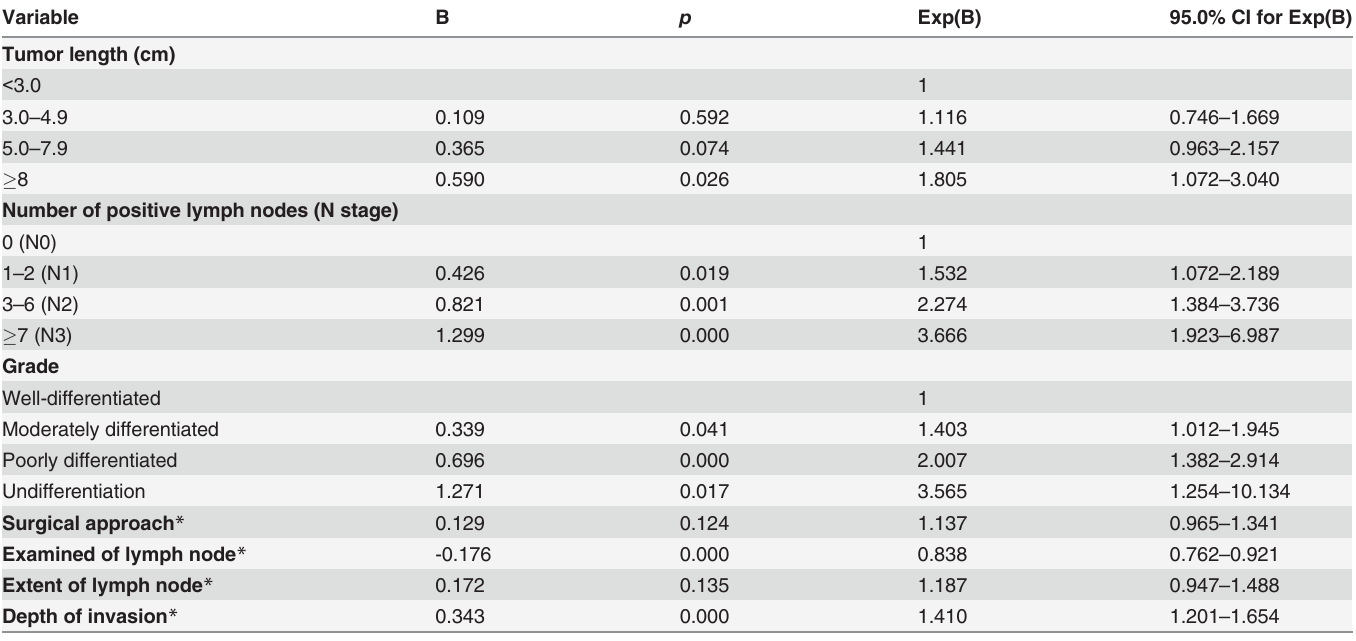
Table 2. Identified variables by Cox Multivariate Regression Analysis in the training